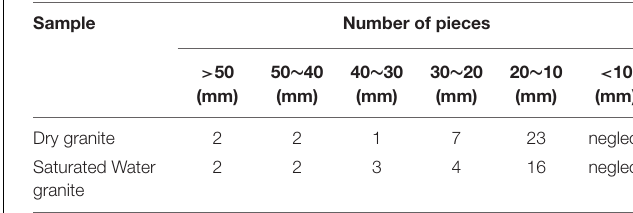
TABLE 2 | Mechanical parameters of dry and saturated water granite.